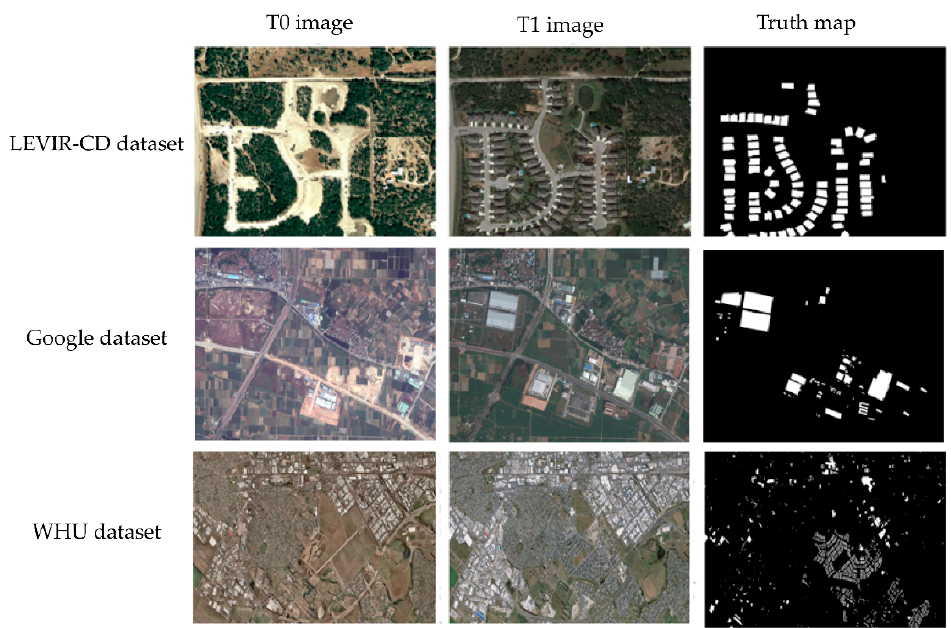
Figure 1. Some examples of the datasets used in this paper.